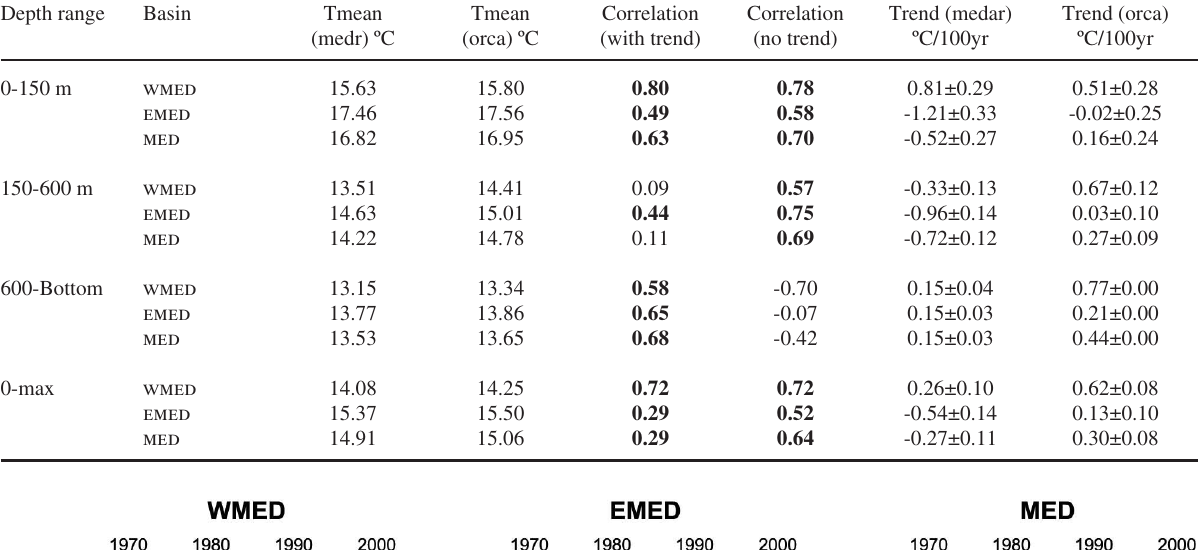
Table 1. – ORCA and MEDAR temperature statistics related to Figure 1. Correlation values that are significant to 99% are in bold. Depth range